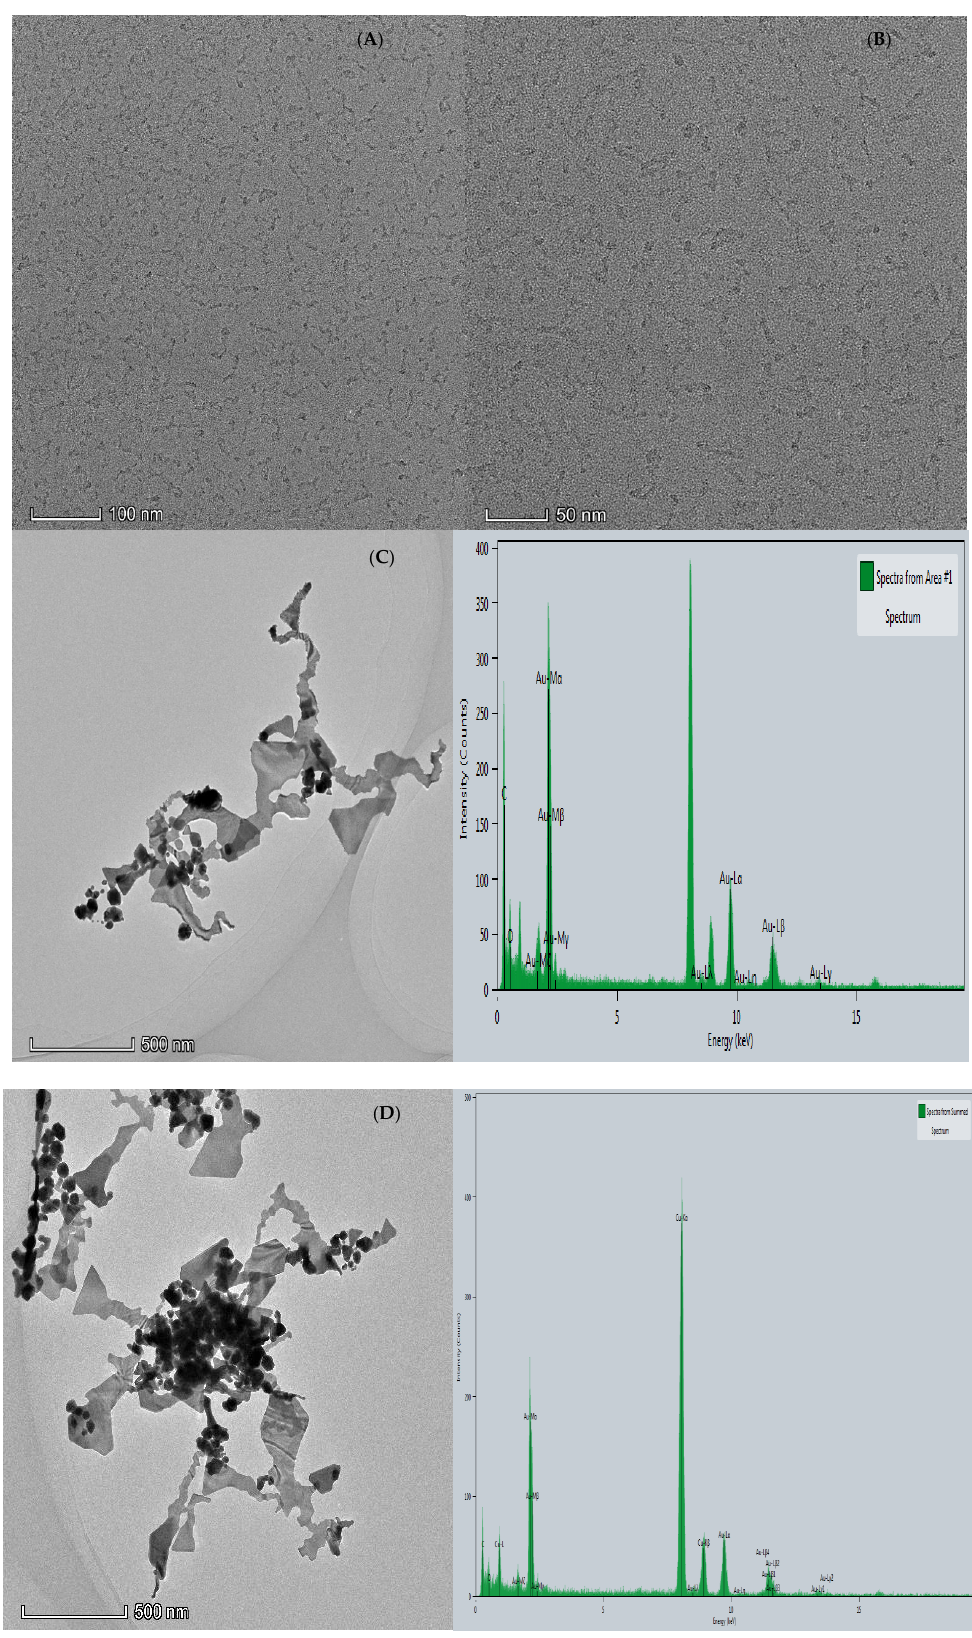
Figure 3. ( A ), ( B ): TEM of CD N ; ( C ): 40 nmol/L Apt As + 2 .94 μg/mL CD N + 9.97% Et + 0.5 mmol/L HCl + 0.07 mg/mL HAuCl 4 ; Figure 3. ( A , B ): TEM of CD N ; ( C ): 40 nmol/L Apt As + 2.94 µ g/mL CD N + 9.97% Et + 0.5 mmol/L HCl + 0.07 mg/mL ( D ): C + 150 nmol/L As 3+ . HAuCl 4 ; ( D ): C + 150 nmol/L As 3+ With a voltage of 350 V and an excitation slit = emission slit of 5 nm, as well as an excitation wavelength of 250 nm, the CD N has a fluorescence peak at 442 nm. Then, the optimal excitation wavelength EX = 362 nm is determined under the condition of EM = 442 nm (Figure 4A). As the increase of CD N concentration the intensity of the fluorescence peak at 442 nm gradually increases (Figure 4B). The CD N has a UV absorption peak at 350 nm, and the absorption peak at 350 nm gradually increases with the increase in the CD N concentration (Figure 4C). Similarly, the CD N also has an RRS peak at 400 nm. As the CD N concentration increases, the intensity at 400 nm gradually increases (Figure 4D).